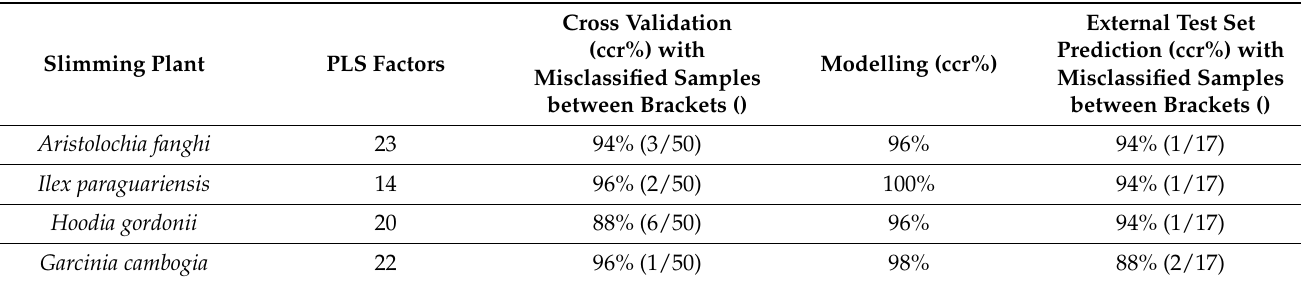
Table 3. Binary modelling using PLS-DA with 67 total samples.